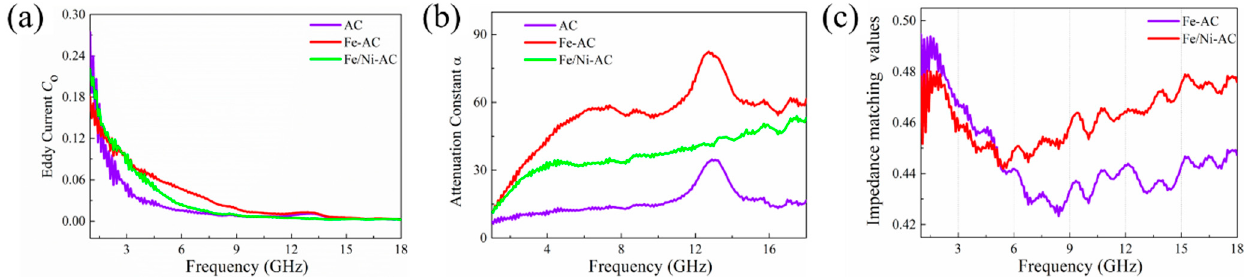
Figure 6. ( a ) Eddy current of AC, Fe-AC, and Fe/Ni-AC; ( b ) attenuation constants of AC, Fe-AC, and Fe/Ni-AC; ( c ) impedance matching coefficient of Fe-AC and Fe/Ni-AC.